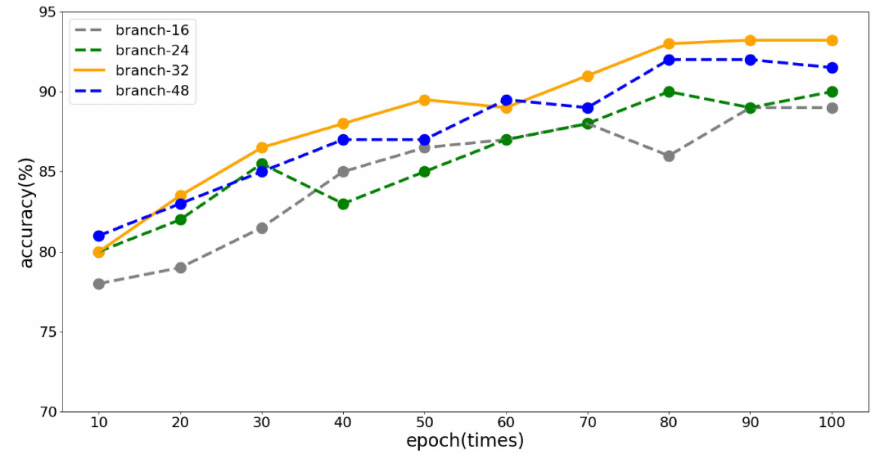
Figure 13. The effect of different numbers of branches on the accuracy